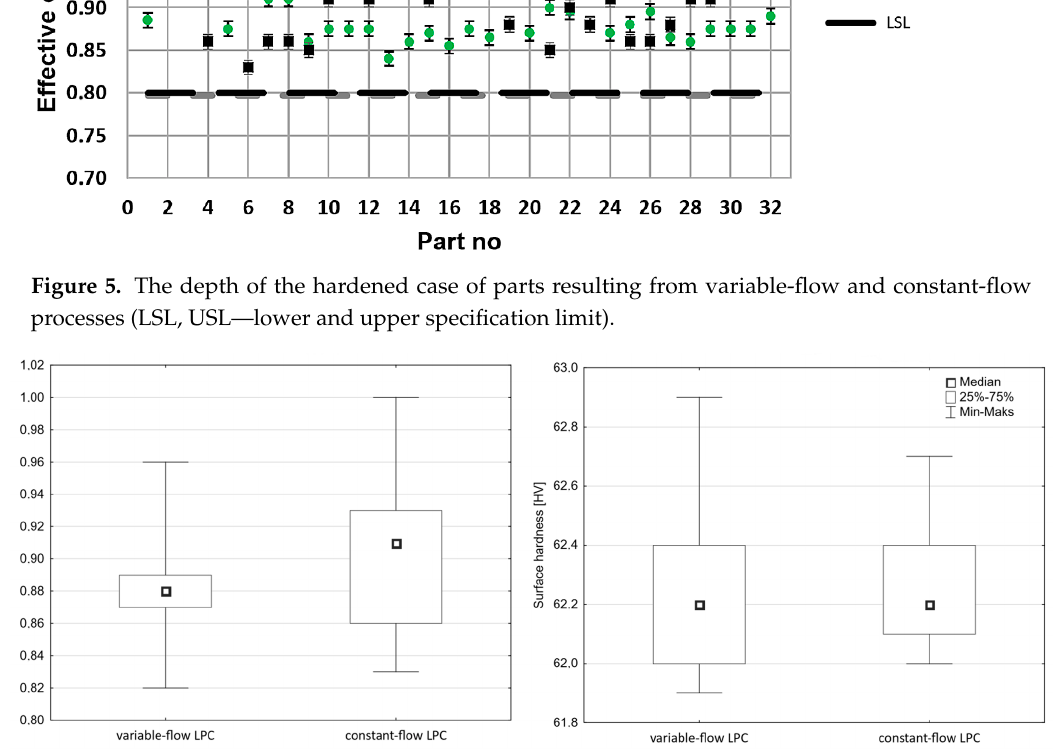
Figure 6. Surface hardness and depth of the hardened case of parts resulting from variable-flow and constant-flow constant-flow processes.